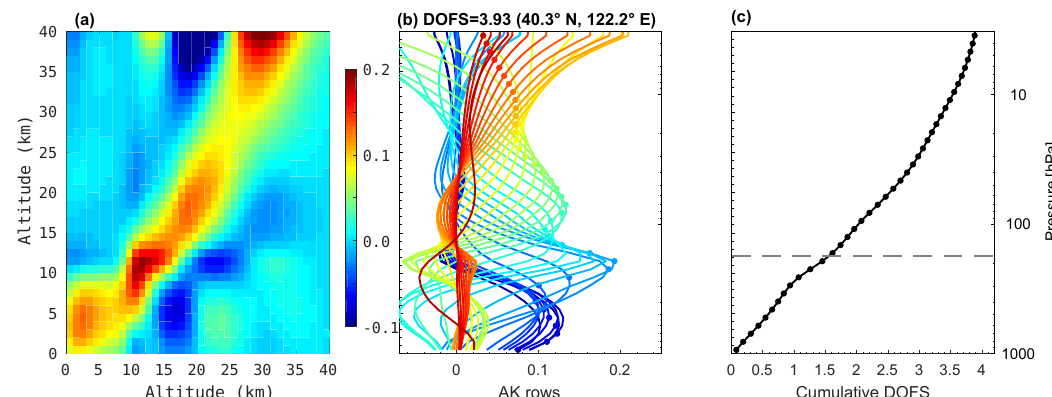
Figure 1. (a) Example of the averaging kernel (AK) matrix for the IASI-A vertical profile retrieval indicating where the information present in the IASI-A vertical ozone profile (horizontal axis) originates from in the atmosphere (vertical axis). (b) Another representation of the AK matrix (each line is a row of the AK matrix); the nominal height of each kernel is marked by a circle. (c) Cumulative DOFS (degree of freedom for signal) obtained from the diagonal of the AK matrix. The AKs expressed in (molecules cm − 2 )/(molecules cm − 2 ) correspond to one daytime midlatitude measurement (40.3 ◦ N, 122.2 ◦ E) obtained on 1 June 2016 for each of the 1km retrieved layers from the surface to an altitude of